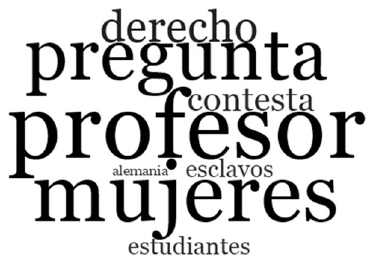
Fig. 1 General cloud mark with an account of the development of active citizenship in the educational contexts observed. This visualization called a cloud mark is the result of the word frequency query that Nvivo allows in this case of the “ Active citizenship ” node: it illustrates the terms or the words that are most often repeated in the references categorized under this node of all the records obtained and indicates — proportionally by size — their greater or lesser presence and relevance in the observations of both sets of teaching materials. The translation of the words from Spanish to English in descending order from highest to lowest is: teacher, women, question, law, answer, slaves, students, Germany. From: Nvivo